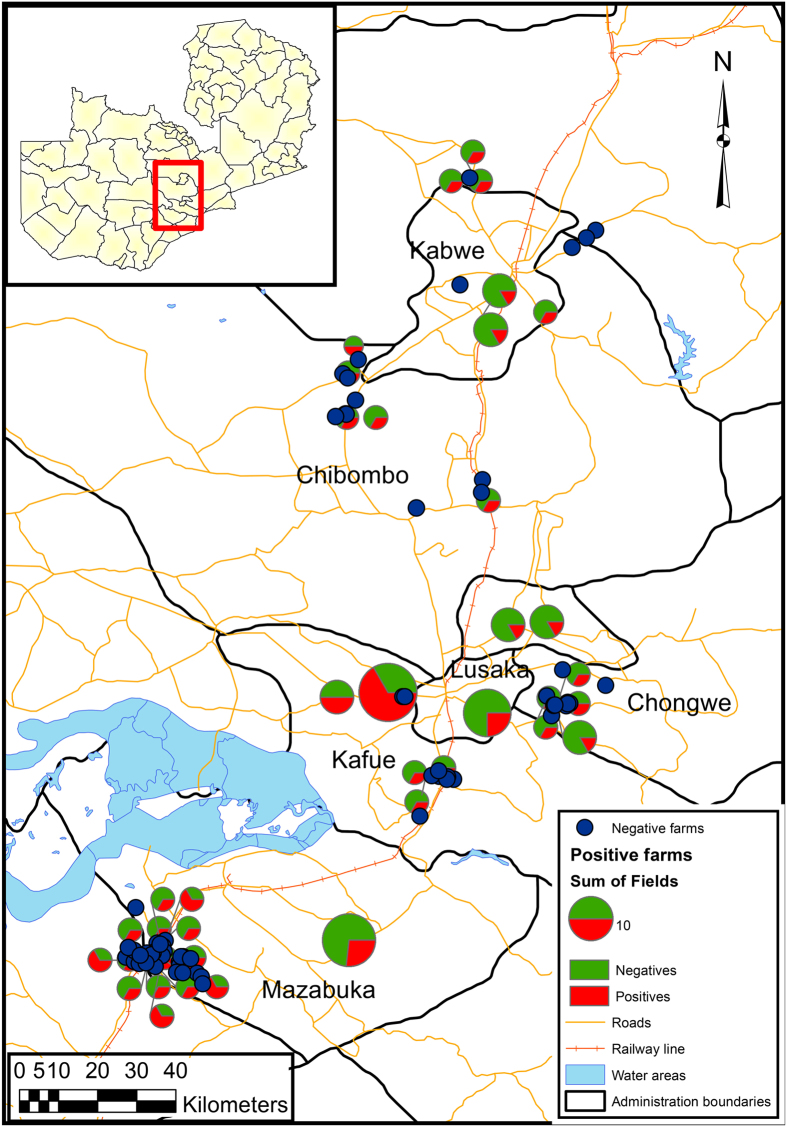
Map of Zambia (insert), depicting the location (red rectangle) of the study farms in the following Zambian districts; Kabwe, Chibombo, Chongwe, Lusaka, Kafue and Mazabuka.The pie charts indicate the relative sample sizes on each farm (ranging from the smallest chart representing 1 animal and the largest representing 18 animals. The legend shows an example of a pie chart representing 10 sampled animals and the red shading equals the proportion of animals that had a resistant isolate. Other features on the map include main roads (orange lines) and water areas (blue features). The map was generated in ARCGIS 10.1 software ARCGIS® (ESRI, ArcGIS desktop: release 10. Environmental Systems Research Institute, CA (2011)). The shape file was downloaded from Diva gis (http://www.diva-gis.org/gdata) and drawn in Arcmap 10.1 data view. The coordinates for the farms were projected in the map and pie charts created within the package.